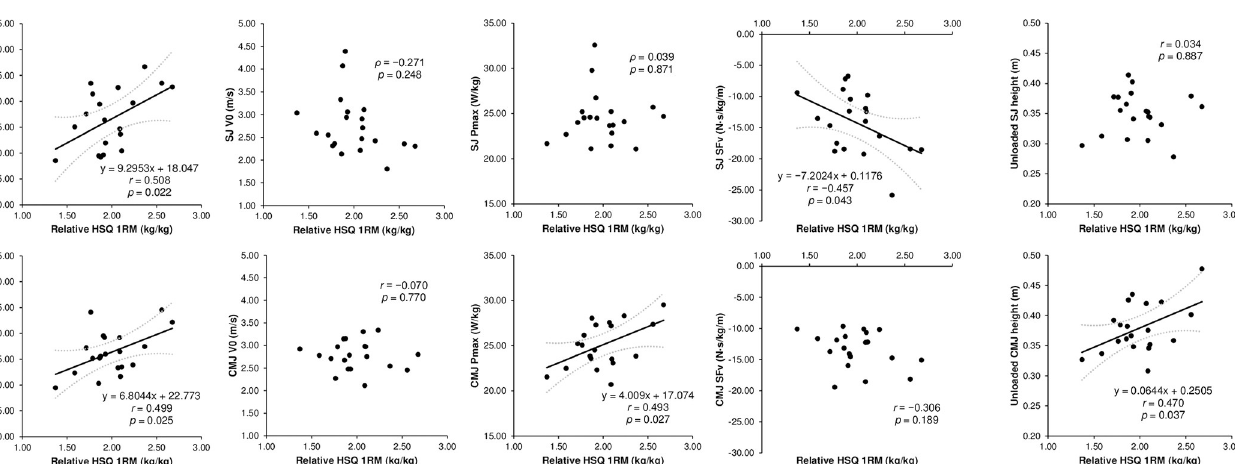
ICC = intraclass correlation coefficient; CI = confidence interval; CV = coefficient of variation; SJ = squat jump; CMJ = countermovement jump; DJ = drop jump; RSI = reactive strength index; F0 = theoretical maximum force; V0 = theoretical maximum velocity; Pmax = theoretical maximum power; SFv = slope of the linear F–v relationship; EUR = eccentric utilization ratio.